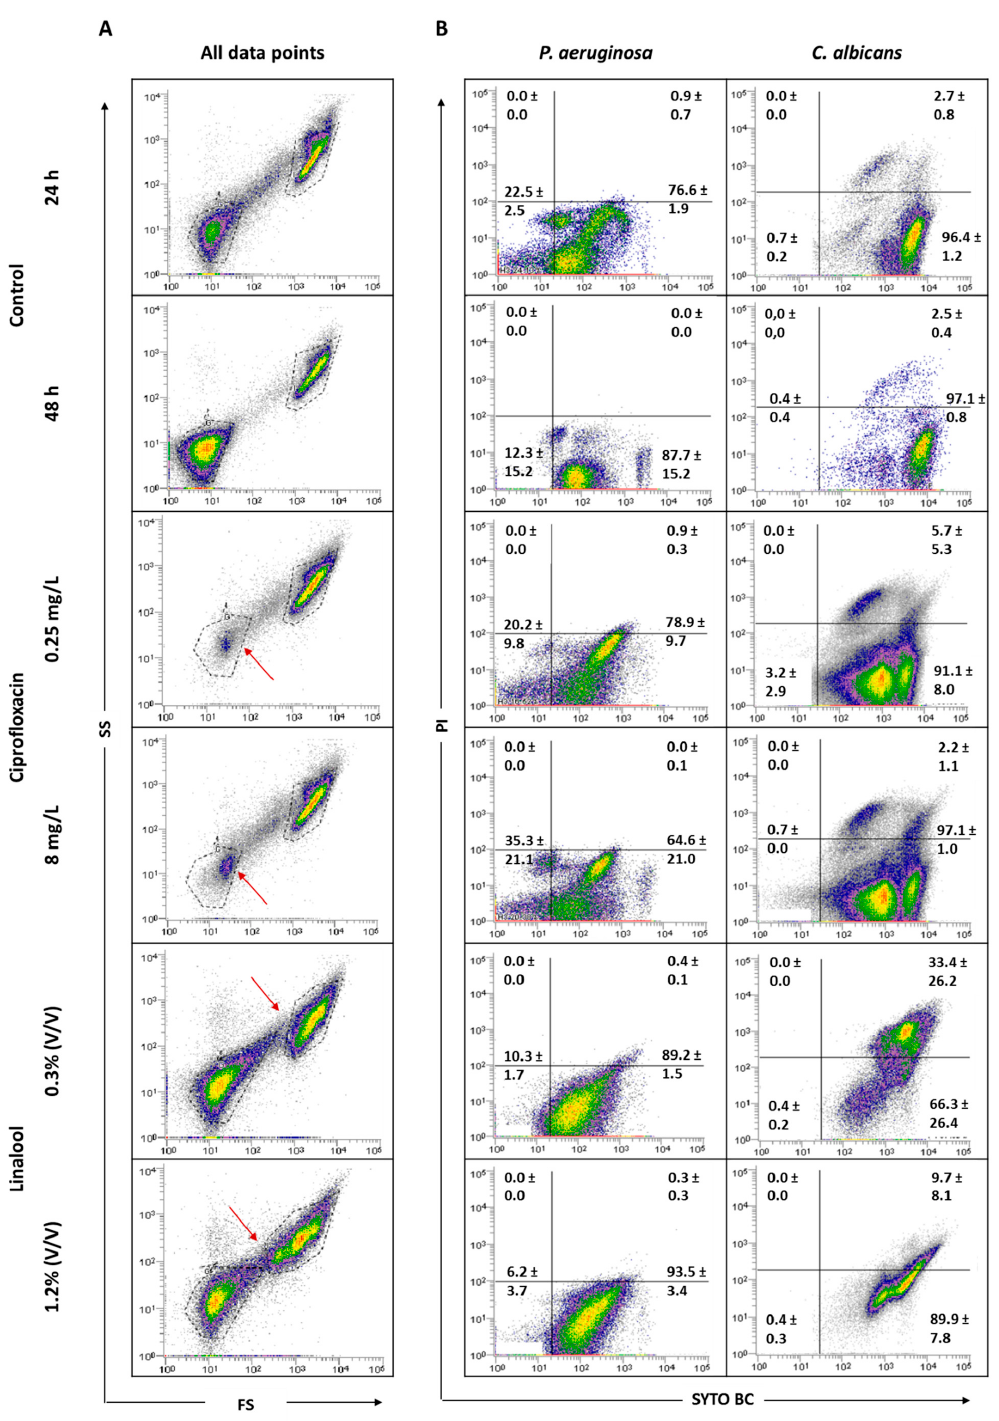
Figure 6. Representative all data points ( A ) and specific dot plots ( B ) obtained for P. aeruginosa PAO1 and C. albicans 547096 mixed-species biofilms by FCM. Dot plots of P. aeruginosa and C. albicans represent the areas delineated to represent bacteria and fungi, respectively. The arrows indicate alterations in the core of the population compared to the